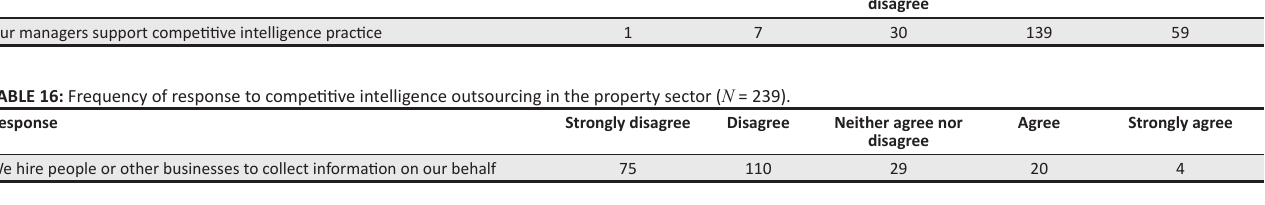
TABLE 17: Frequency of response to the impact of competitive intelligence performance measurement on profit in the property sector ( N = 239). Response